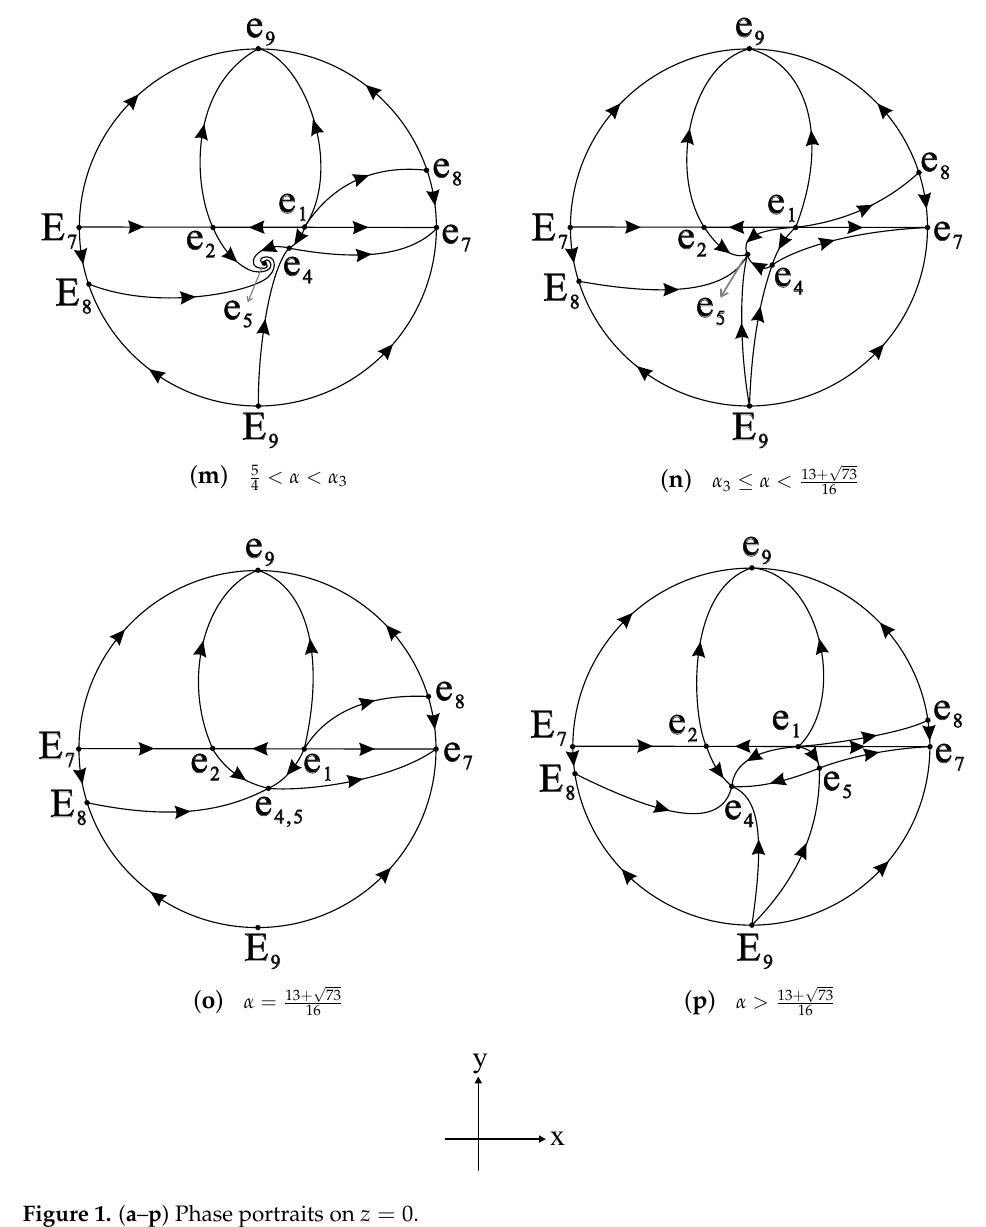
Figure 1. ( a – p ) Phase portraits on z =